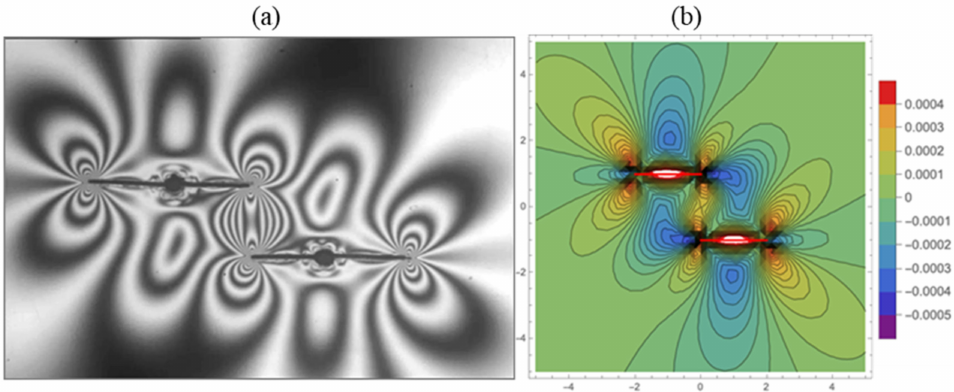
Figure 3. ( a ) Photo-elastic color fringes in pressured in visualizing strain magnitude contours, after Ramesh and Sasikumar [25]. Original image kindly provided by Dr. Ramesh. ( b ) Corresponding solutions obtained with LSM code. The color bar shows strain